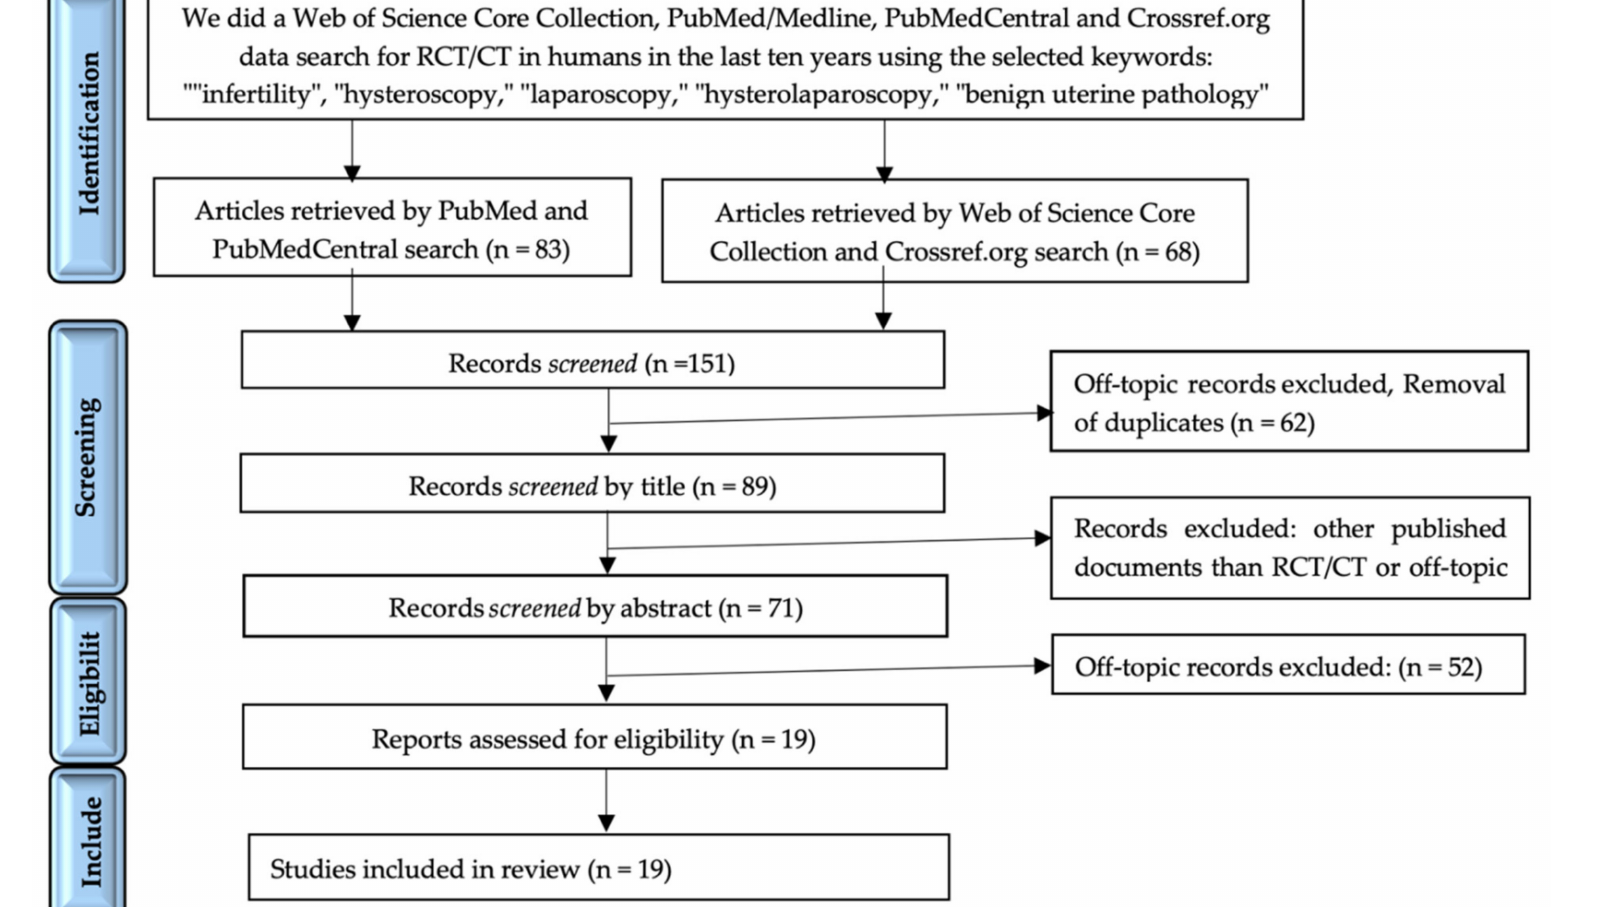
Figure 1. PRISMA diagram—systematic search and study selection